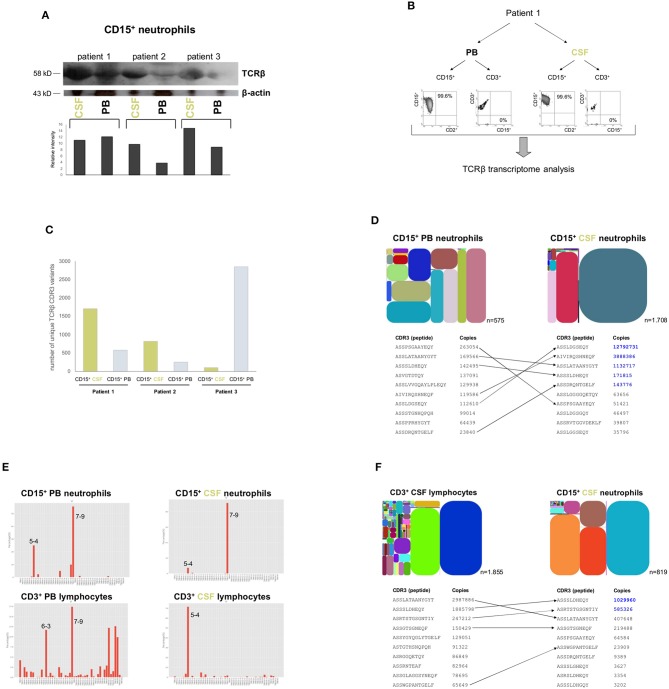
Induction of the variable TCRαβ in CSF neutrophils during the acute phase of bacterial meningitis. (A) The Western blot shows TCRαβ levels in CD15+ neutrophils from acute phase CSF (<15 h post-onset of symptoms) and simultaneously collected peripheral blood (PB) in patients with bacterial meningitis caused by S. aureus (patient 1), S. pneumoniae (patient 2) and E. coli, respectively (patient 3). A quantitative analysis of the TCRβ western blot signals in relation to β-actin are shown below. β-actin, protein loading control. The original blots this figure is based on are displayed in the Supplementary Material. (B) Experimental design of dual lineage NGS-based TCRβ transcriptome analyses in patients with acute bacterial meningitis (representatively shown for patient 1). Highly pure CD15+ neutrophils and CD3+ lymphocytes were obtained simultaneously from the patients' peripheral blood and CSF, respectively, and TCRβ transcriptomes were analyzed by ARM-PCR based high-throughput sequencing. The scattergrams document the purity of the isolated cell fractions. (C) Sequencing of the TCRβ transcriptomes of patients 1–3 reveals that the unique number of expressed TCRβ CDR3 variants is higher in CD15+ CSF neutrophils of patient 1 and 2 than in CD15+ PB neutrophils indicative of repertoire broadening at the site of inflammation. Shown are the unique TCRβ CDR3 variants. A unique CDR3 sequence is defined as a non-redundant fragment of amino acids which is derived from a stop-codon-free reading frame containing both translated conserved V and J motifs. An overview of the NGS results including effective reads, unique and total CDR3 numbers are shown in Table S2. (D) (top) Repertoire diversity tree plots visualize the relative abundance of the TCRβ CDR3 transcript variants that are expressed by CD15+ neutrophils in CSF and in peripheral blood (patient 1). Each spot represents a rearranged TCRβ transcript that encodes a unique CDR3β sequence. It is defined by a unique color and its area is proportional to the relative transcript frequency. The position of each spot within the plot area is defined according to its Vβ usage (x-axis: Vβ1 → Vβi) and Jβ usage (y-axis: Jβ1 → Jβi). Each plot has a distinct color code. Total numbers of identified non-redundant (“unique”) TCRβ CDR3 sequence variants are indicated for each diversity tree plot. CDR3, complementarity determining region 3. (bottom) Detailed list of the 10 most frequently expressed TCRβ CDR3 variants in each neutrophil population. Transcript copy numbers are indicated. TCRβ variants that are shared between PB and CSF neutrophils are connected by arrows. TCRβ variants that show an increase in CSF neutrophils are highlighted in blue. See also Figure S13. (E) Vβ gene usage of CD15+ neutrophils and CD3+ lymphocytes, respectively, in peripheral blood and CSF (patient 1). The 2D-plots demonstrate the relative usage of the Vβ genes for each cell compartment. This analysis is based on the number directly observed from the read count data. Note the markedly restricted Vβ gene usage in CSF cells relative to PB cells. X-axis: Vβ gene; y-axis: percentage of used Vβ genes. A normalized distribution of the Vβ gene usage is shown in Figure S15. (F) (top) Relative abundance of TCRβ CDR3 transcript variants expressed by CD15+ neutrophils and CD3+ lymphocytes in CSF (patient 2). Total numbers of identified non-redundant TCRβ CDR3 sequence variants are indicated for each leukocyte subpopulation. (bottom) Comparison of the 10 most frequently expressed TCRβ CDR3 variants reveals that neutrophils and lymphocytes in CSF share common repertoires (arrows), but also express a similar proportion of distinct TCRβ variants. Numbers designate transcript copy numbers. Note that two of the shared TCRβ CDR3 sequence variants exhibit higher expression rates in CSF neutrophils than in CSF lymphocytes (blue). See also Figure S16.